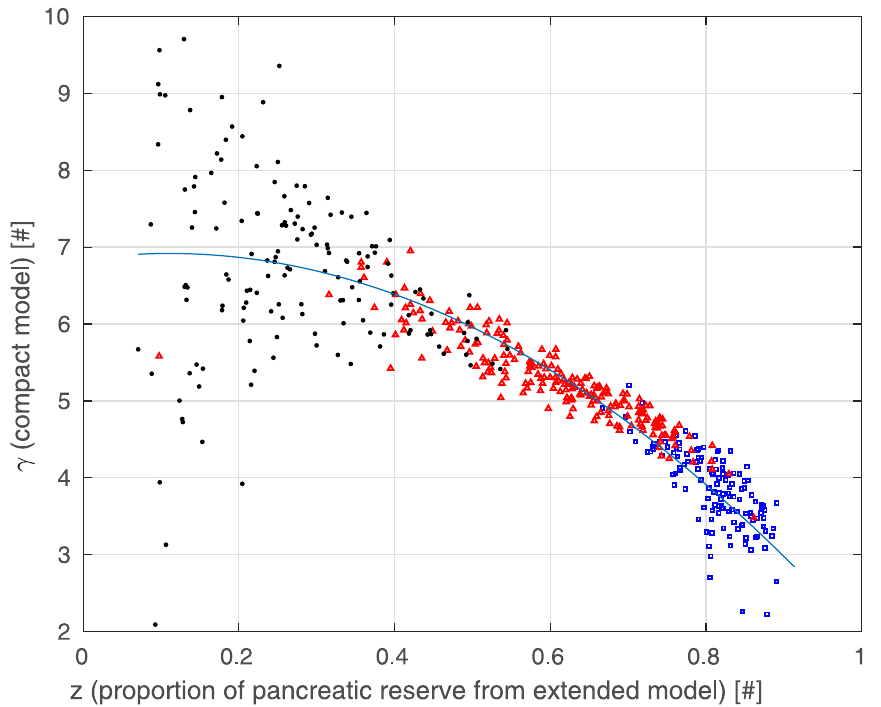
Fig 11. Dependence of estimated Compact Model parameter γ from proportion of pancreatic reserve z (extracted from generating Extended Model data) for NGR (blue squares), pre-diabetic (red triangles) and T2DM (black dots) patients.